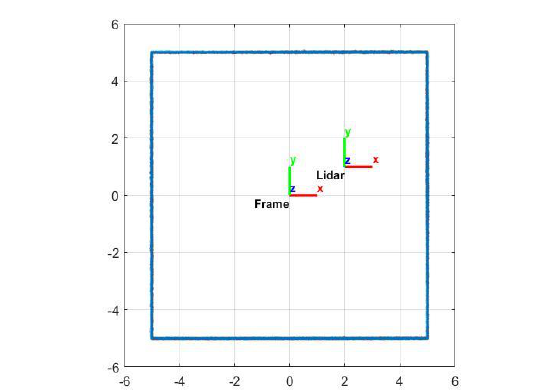
Figure 3. Scanning position of the LIDAR in the room